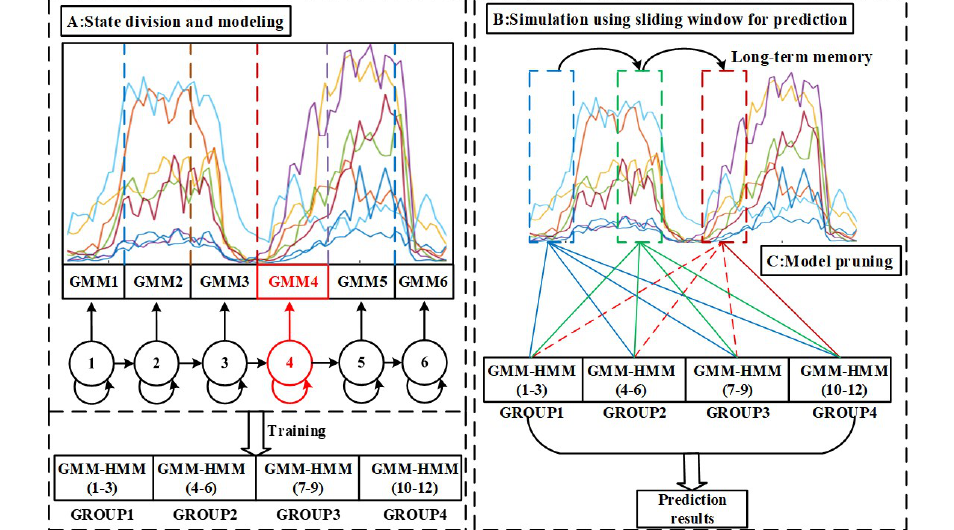
Figure 1. The structure of the proposed prediction framework. Part A illustrates the state division and modeling process; state 4 is the key state transition of the setting. Twelve models are trained and then divided into four groups according to the different starting gestures of continuous two-hand actions. Part B displays the prediction simulation process using a sliding window with long-term memory. Based on Part A and Part B, Part C performs model pruning; the groups pointed by the dotted line are